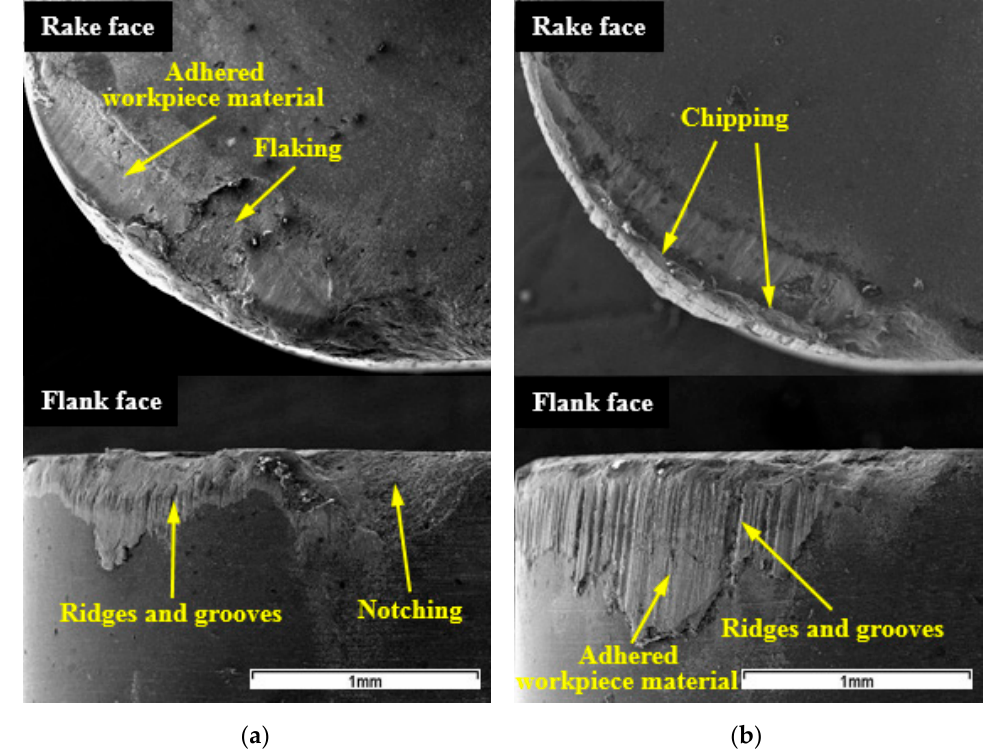
Figure 4. SEM micrographs of wear morphologies of SX9 at: ( a ) 150 m/min; ( b ) 250 m/min.